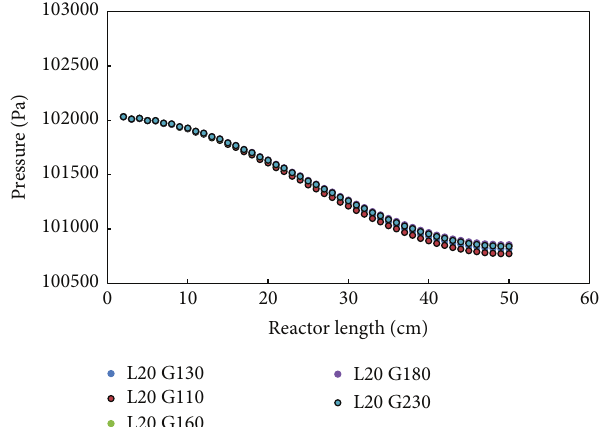
Figure 10: Calculated gas velocity profiles along the reactor for a liquid flow rate of 20 mLmin −1 and various gas flow